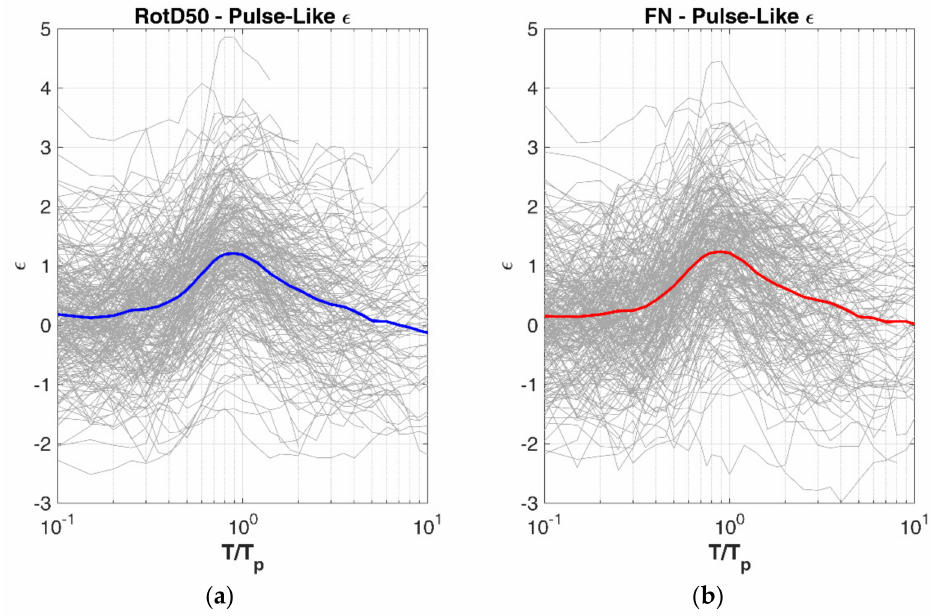
Figure 9. Normalized residuals ε of acceleration response spectra in NESS1 for RotD50 ( a ) and FN ( b ) pulse-like